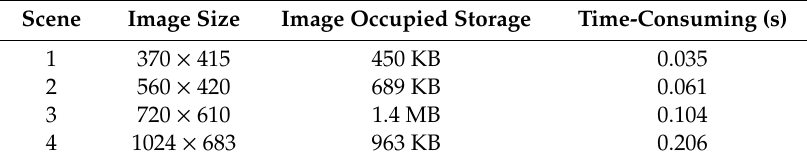
Figure 19. Enhancement effect of four low illumination color scene images: (a) scene 1, (b) scene 2, (c) scene 3, and (d) scene 4. Table 4. Time required to enhance different-sized low illumination color images.